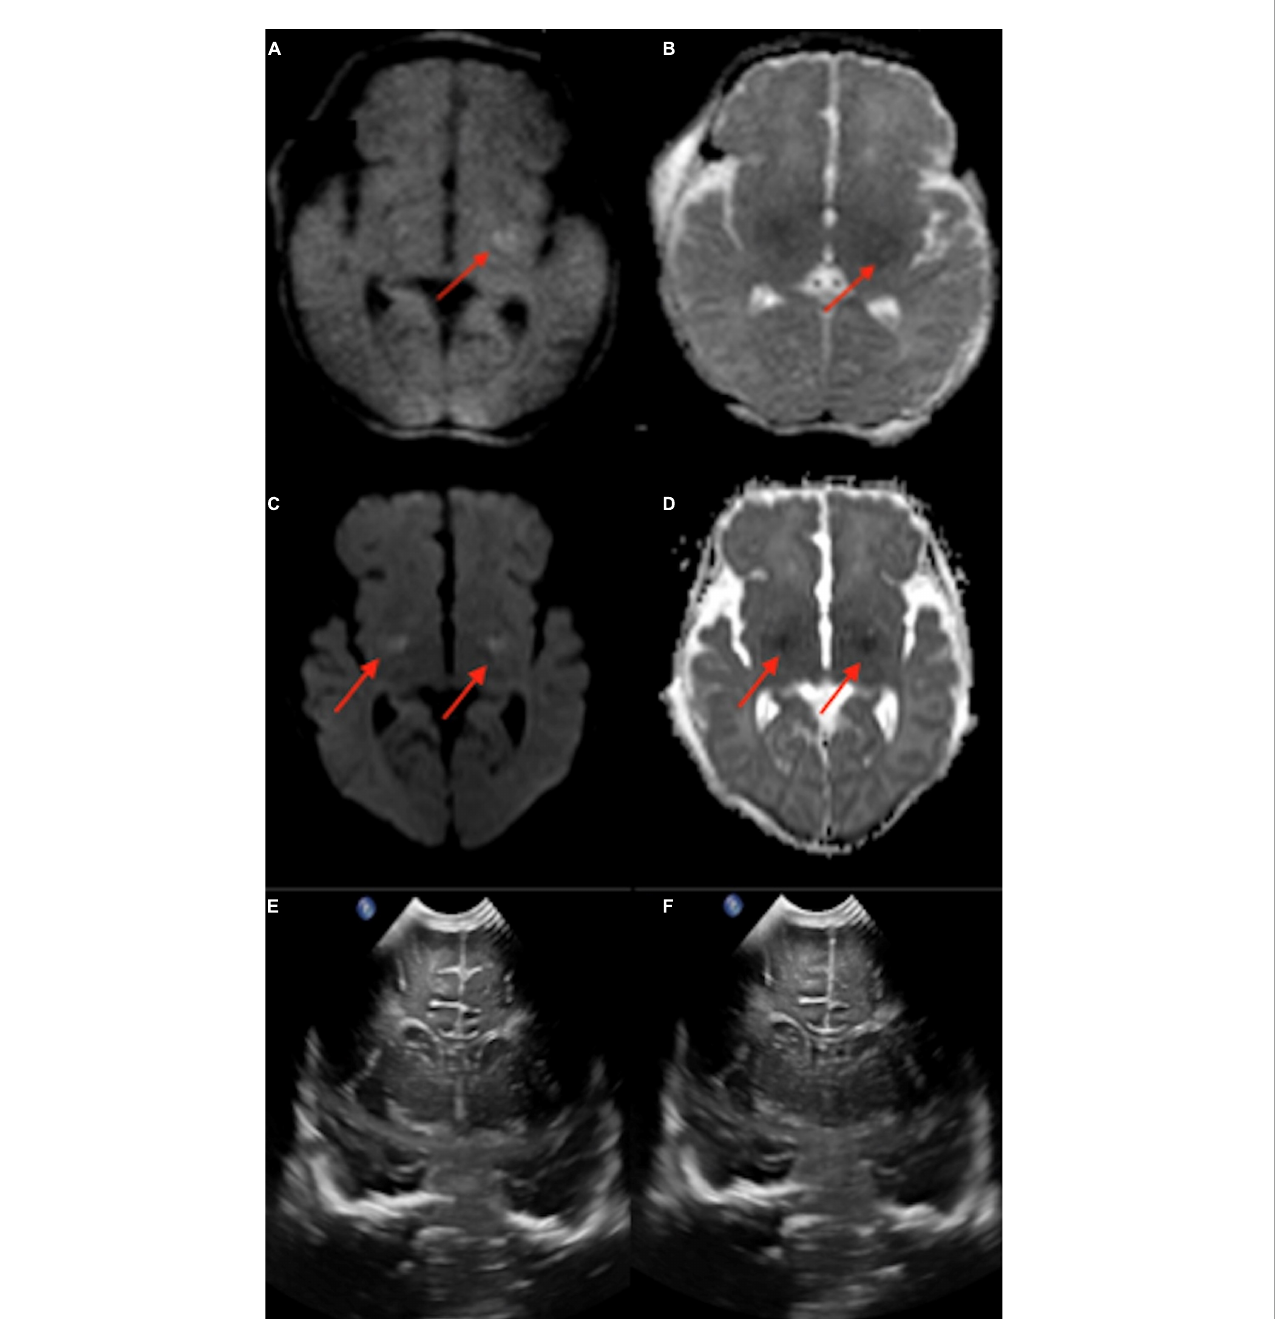
FIGURE1 In a 4-day-old term neonate with challenging home birth, followed by transfer to hospital, resuscitation, and therapeutic hypothermia, the point-of-care 1-Tesla DWI (A) and ADC (B) showed reduced diffusion in the left basal ganglia. The next day (5 days old) follow-up 3-Tesla DWI (C) and ADC (D) showed ischemic changes and reduced diffusion in bilateral basal ganglia. Transcranial ultrasound was normal on the first day after birth (E,F) .